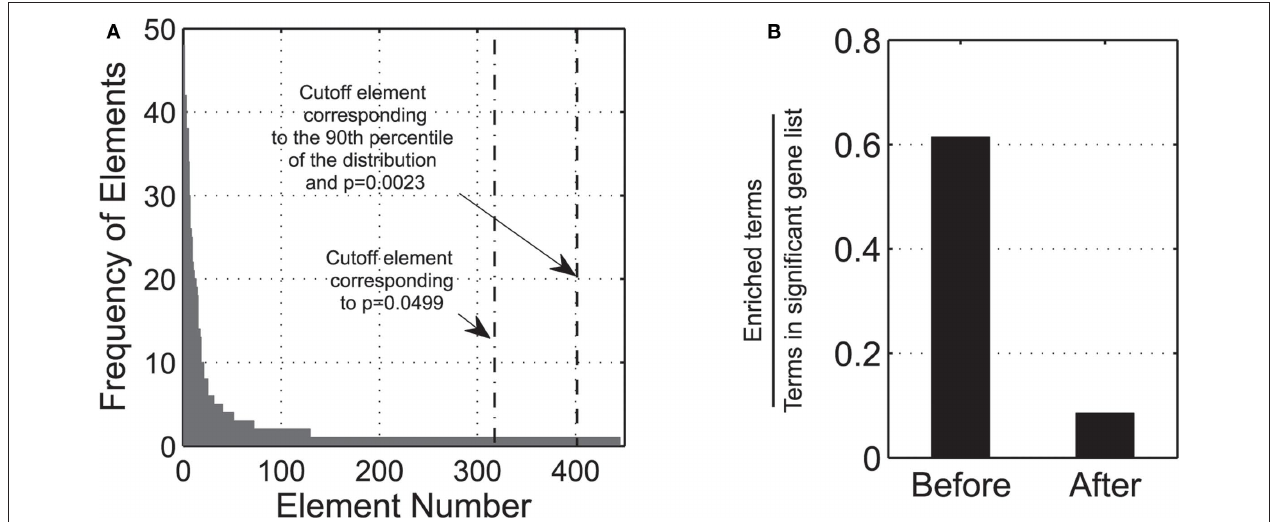
application of solely an enrichment score p -value cutoff. The finite nature of the enrichment statistical tests renders the analysis extremely sensitive to false positives, and thus tremendously error prone, due to bias infiltration, as many terms can obtain technically a high statistical score. The right bar labeled “After” depicts the same ratio after the application of StRAnGER algorithm. The graphs are based on the data presented in Moulos et al.